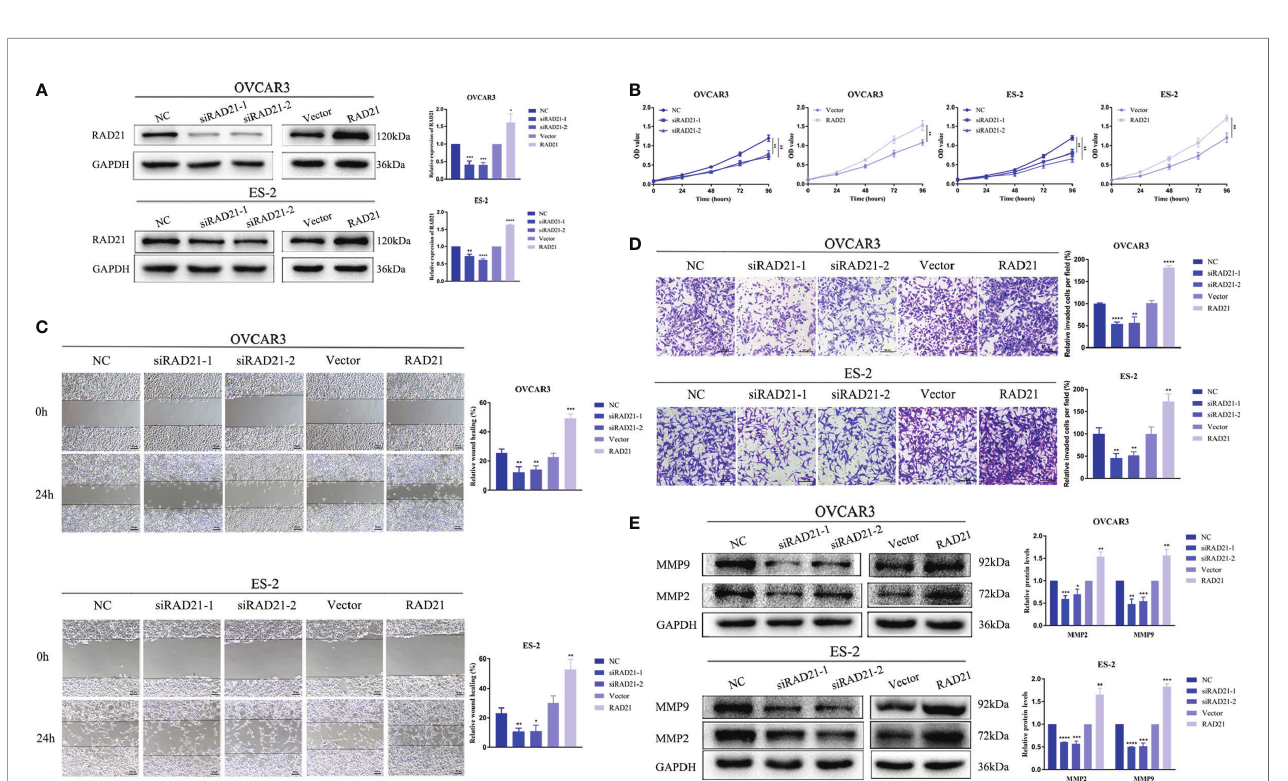
FIGO, International Federation of Gynecology and Obstetrics; LN, lymph node. *p < 0.05.